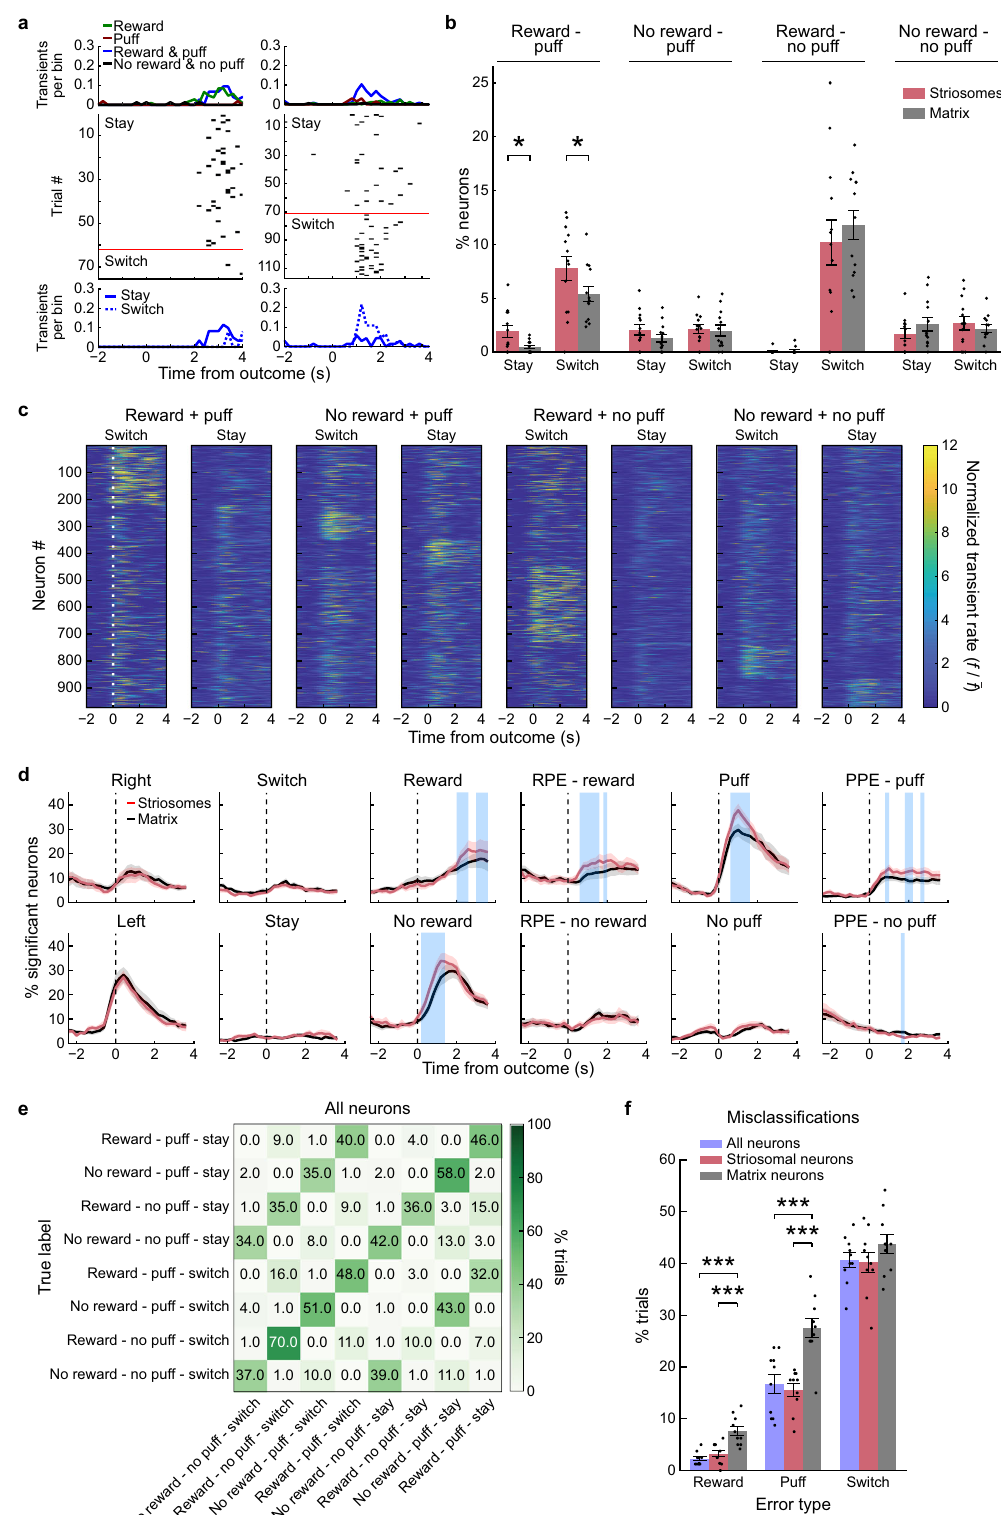
expressing D1 receptors 49,58,59 . Our model also suffers from this attributes of SPNs clustered together in visually identi fi ed strio- some and matrix compartments. problem 52 – 54 , but has the advantage of labeling the neuropil in Visual identi fi cation of these SPN subtypes is critical, because the birthdate-labeled striosomes, which made it possible to genetic models that label striosomes have labeling in the matrix identify visually the striosomal modules with high reliability 53 . (false discovery rate: ~25%), label striosomes sparsely (false We also emphasize that the results here were all obtained by negative rate: ~70%) and are highly biased to striosomal neurons imaging fi elds in the anterodorsal striatum, including the region NATURE COMMUNICATIONS| (2022) 13:1541